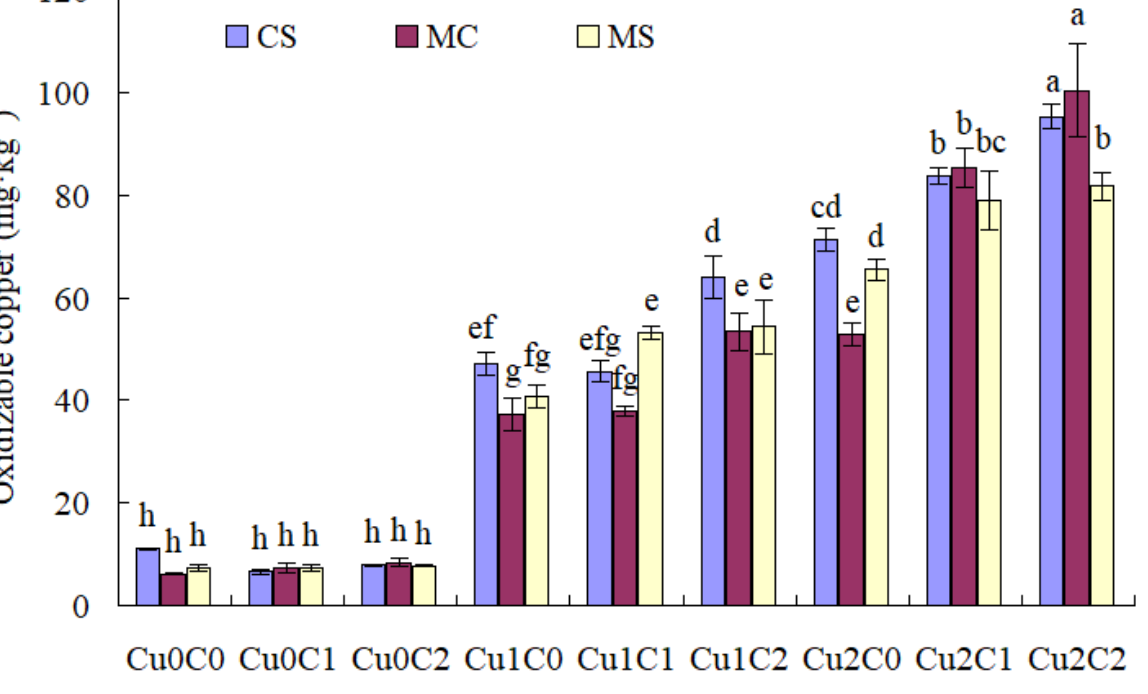
Figure 3. Soil oxidizable copper concentration under different treatments. The different small letters above each column mean significantly different at p <0.05.